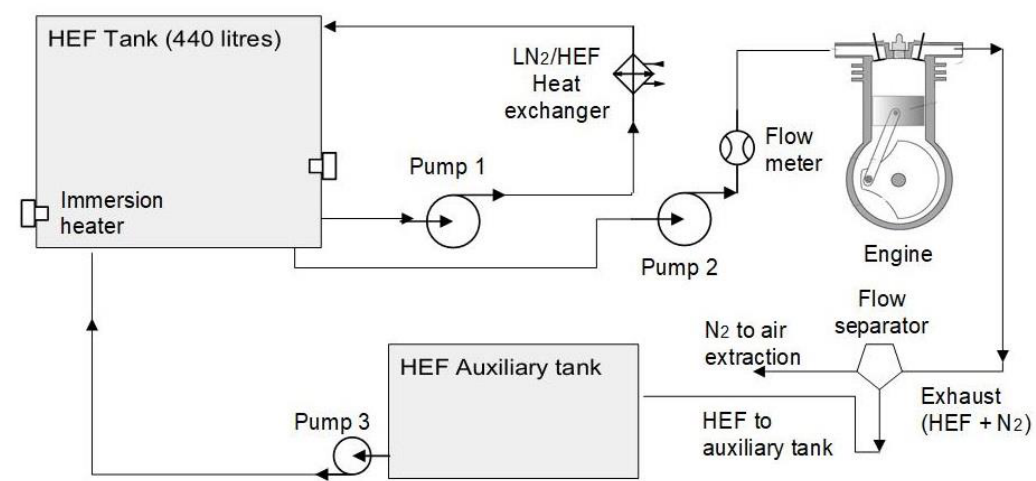
Figure 3. Heat exchange fluid (HEF) storage and supply subsystem.